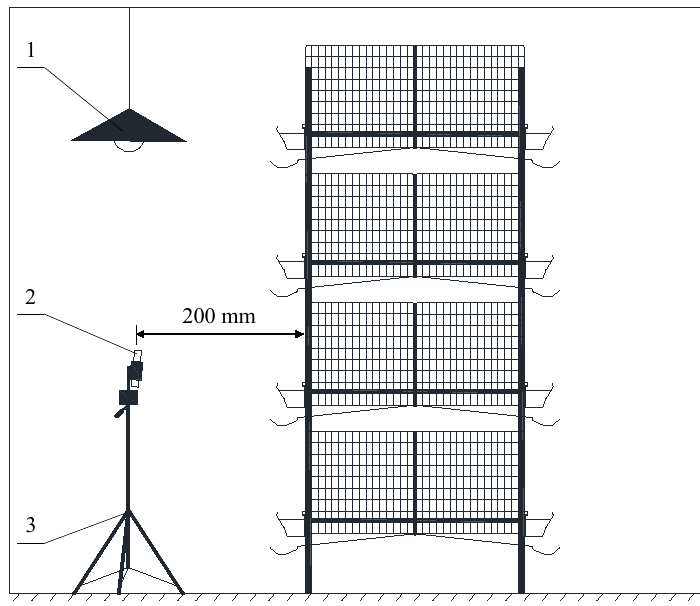
Figure 4. Schematic diagram of duck house layout: (1) light source of duck house, (2) photographic equipment, (3) tripod.